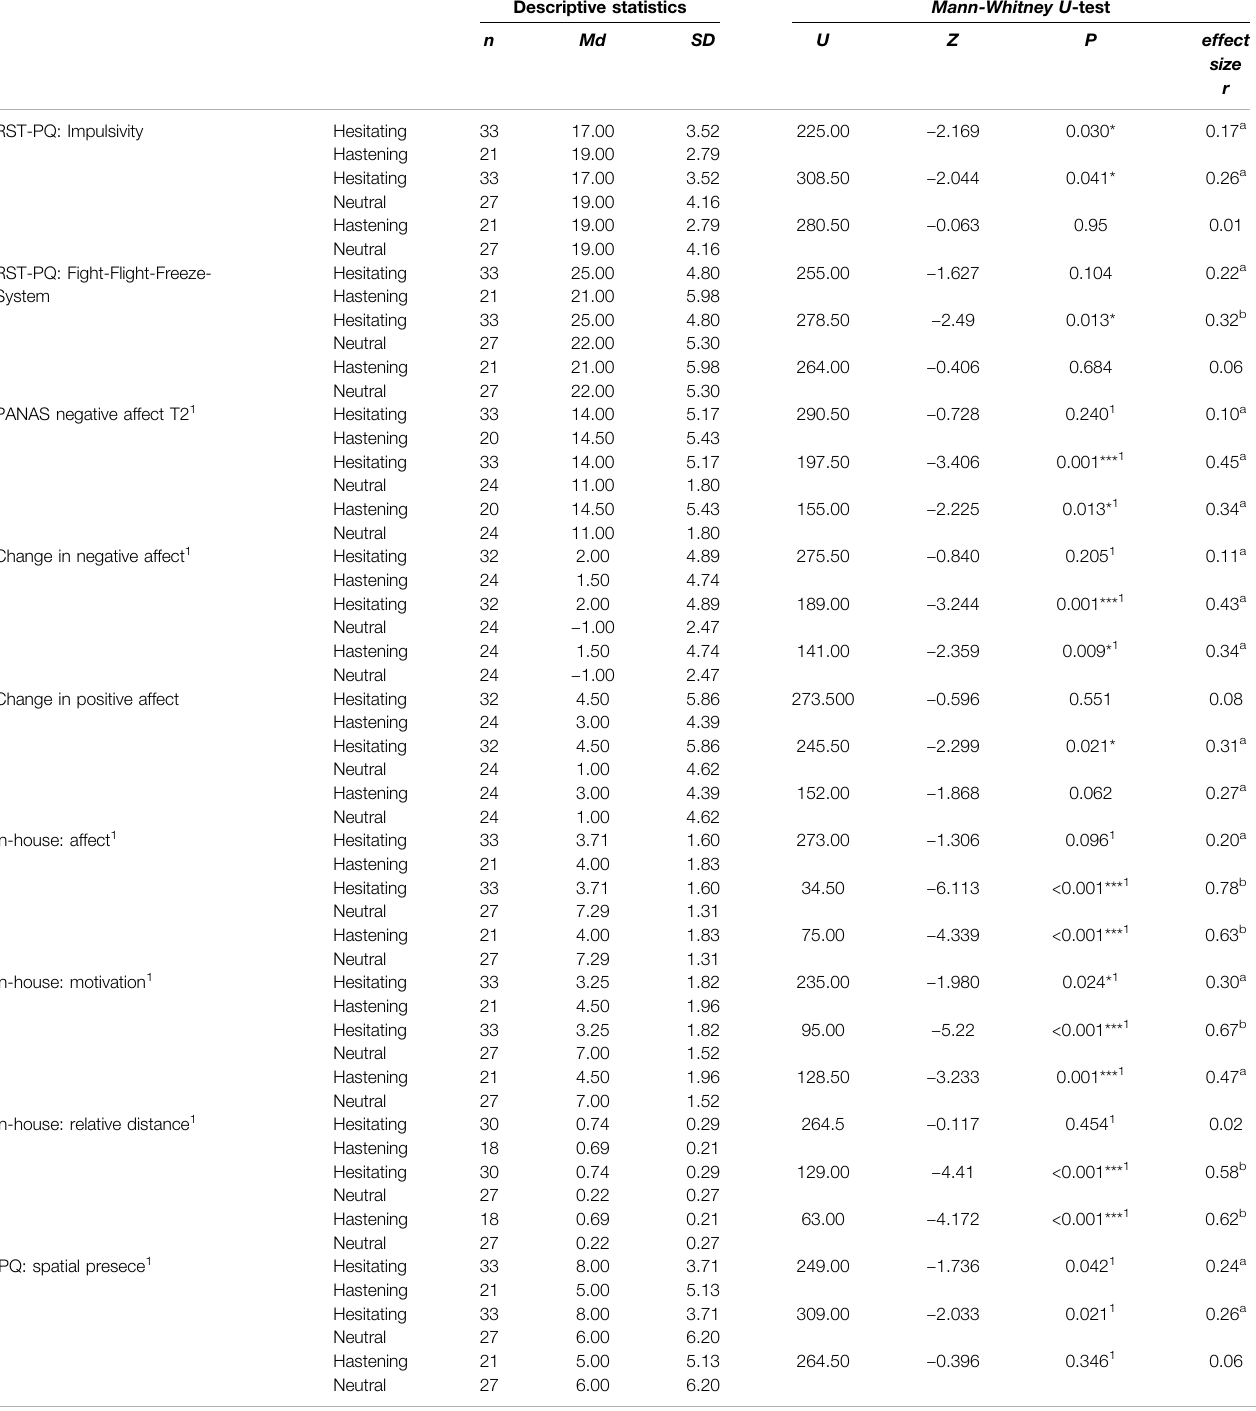
TABLE 1 | Test statistics for Mann-Whitney U-test regarding the subjective